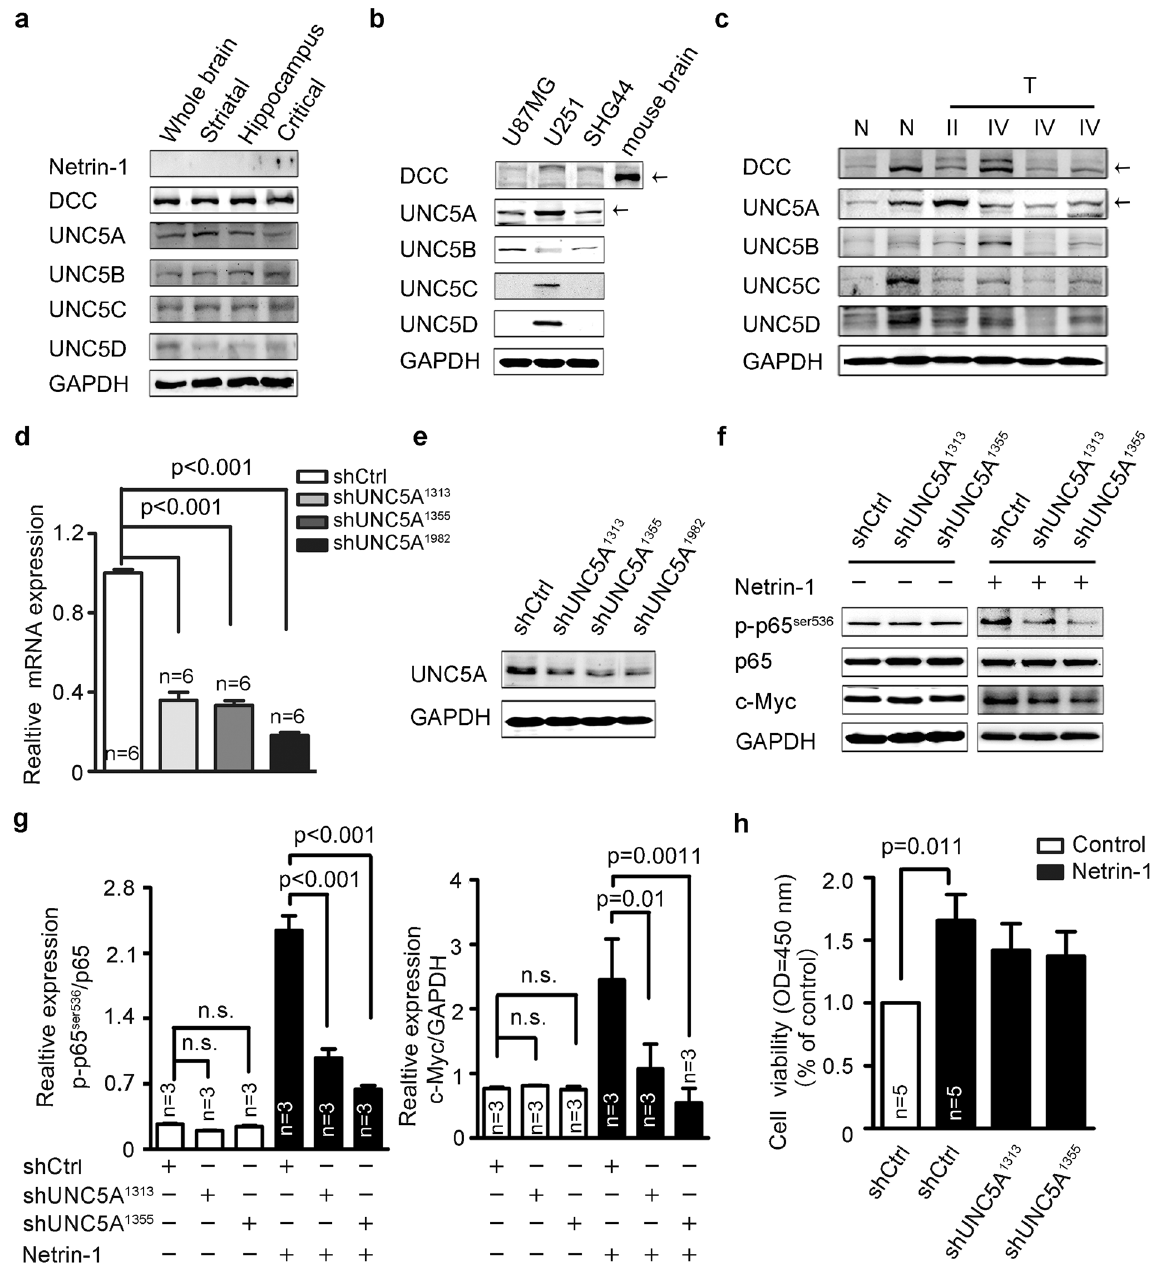
Figure 7. Netrin-1 activation of the NF- κ B pathway was dependent on its canonical receptor UNC5A. ( a ) Western blotting analysis of canonical receptors of netrin-1 in the adult mouse brain. ( b ) Western blotting analysis of canonical receptors of netrin-1 in U87MG, U251 and SHG44 cells. ( c ) Western blotting analyses of canonical receptors of netrin-1 in glioma tumor tissues (T) and normal brain tissues (N) from clinical samples. ( d and e ) UNC5A mRNA and protein expression levels were determined by real-time PCR and western blotting in U251 cells infected with lentivirus expressing shCtrl or shUNC5A. ( f ) Western blotting analysis of p65 ser536 and c-Myc in U251 cells infected with lentivirus expressing shCtrl or shUNC5A with or without netrin-1 stimulation. ( g ) Quantification of p65 ser536 phosphorylation using Gel-Pro Analyzer 4 software. Phosphorylation of NF- κ B p65 ser536 was normalized to total p65, and c-Myc was normalized to GAPDH. ( h ) CCK-8 assays revealed that the addition of netrin-1 promoted cell proliferation. On the contrary, silencing of UNC5A blocked netrin-1-induced cell proliferation. The data are shown as the mean ±